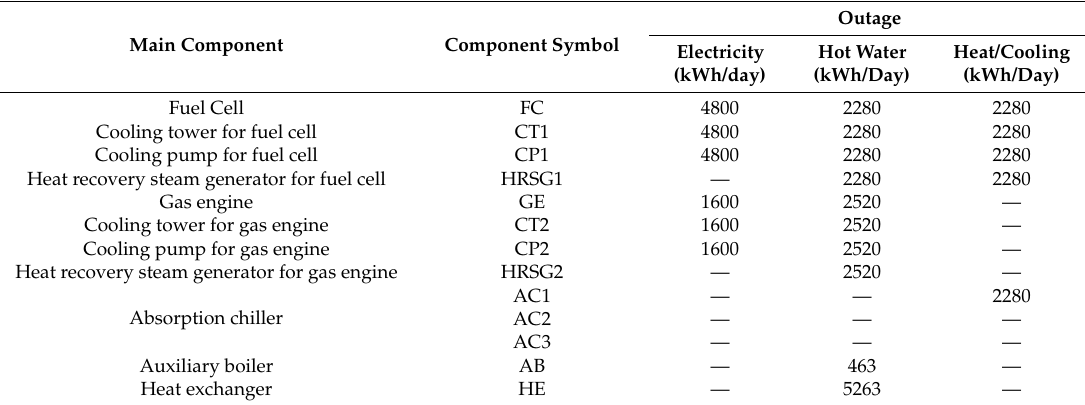
Figure 13. The CI values of the components of the CCHP system. Table 12. The outage data of electricity, space cooling and heating, and hot water due to component failure.